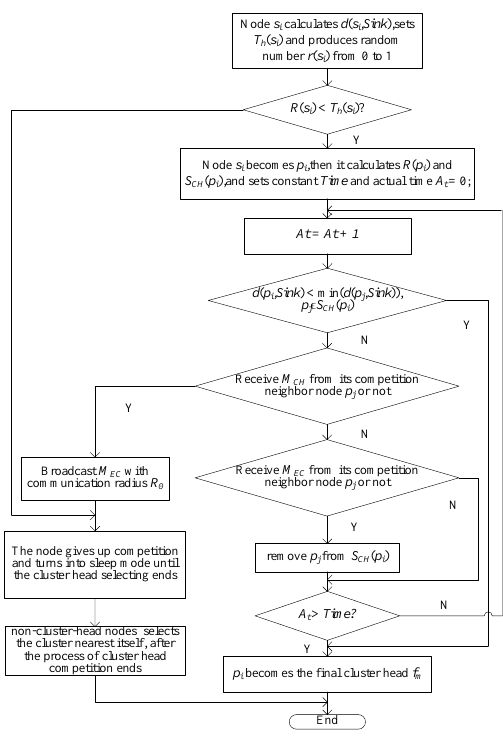
Figure 3. Flow chart of Section 3.2.1.